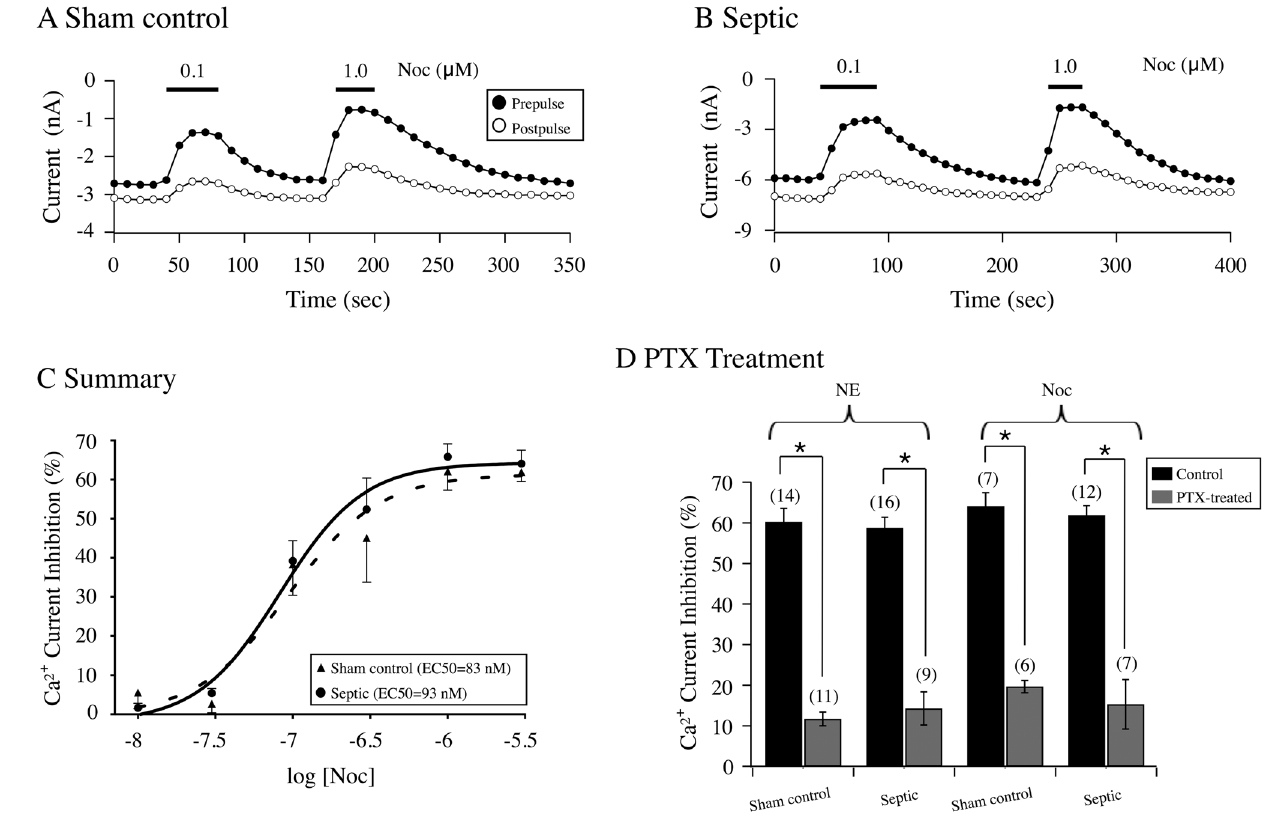
Fig 4. Time courses of Ca 2+ current amplitude for prepulse ( ● ) and postpulse ( (cid:1) ) acquired from the application of Noc in acutely isolated CSMG neurons from sham control (A) and septic (B) rats 48 hr post-sepsis induction by CLP. Ca 2+ channel currents were evoked as described for Fig 3. C, Noc concentration-response relationship of CSMG neurons from sham control ( ▲ ) and septic ( ● ) rats. Each data point represents the mean ( ± SE) Noc- mediated prepulse current inhibition from 4 to 12 neurons. Both smooth curves were obtained by fitting the points with the Hill equation and the fits were not significantly different (P = 0.95). The legend indicates the EC 50 values (nM). D, effect of overnight pretreatment with PTX (500 ng/ml) on the NE (10 μ M)- and Noc (3 μ M) — mediated Ca 2+ current inhibition in both sham control and septic rats. Plot indicates the mean ( ± SE) current inhibition produced by NE and Noc. Numbers in parenthesis indicate the number of neurons tested. * indicates P < 0.05 compared to each respective control, unpaired t -test.